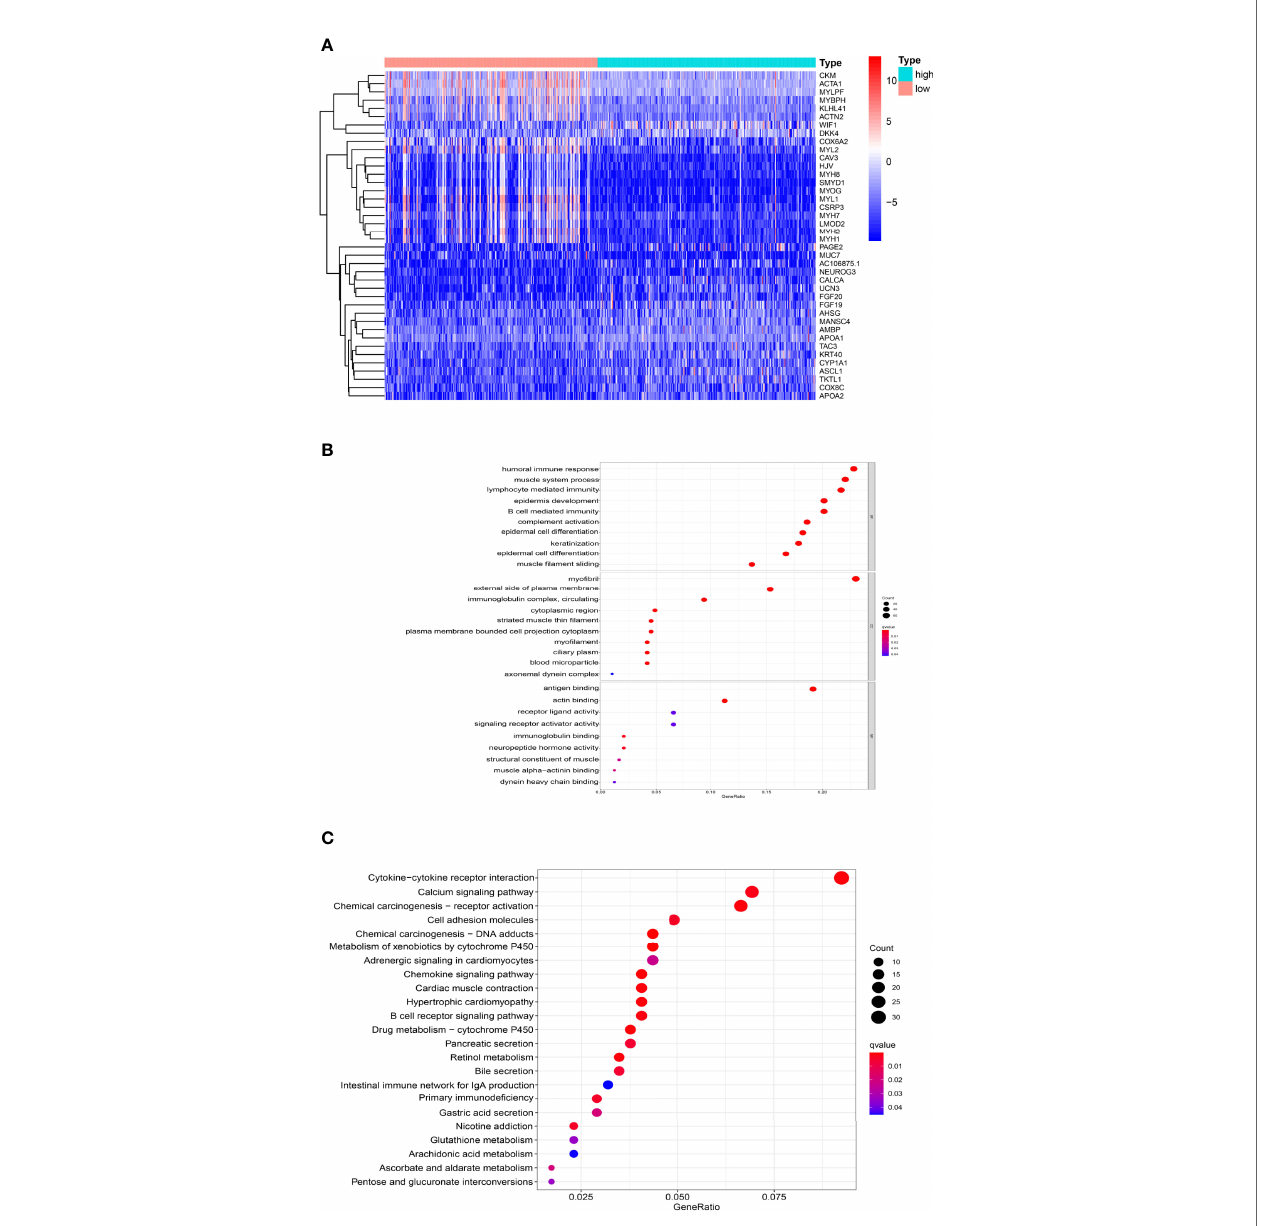
FIGURE 3 | Transcriptome analysis of high TMB and low TMB groups (A) The heatmap showed the top 40 DEGs between two TMB groups. (B) GO analysis revealed that DEGs were involved in muscle system process, the activity of epidermal cells and immune-related function. (C) KEGG pathway analysis of DEGs was found in immune signal mediation, cytochrome P450, cytokine regulation signaling